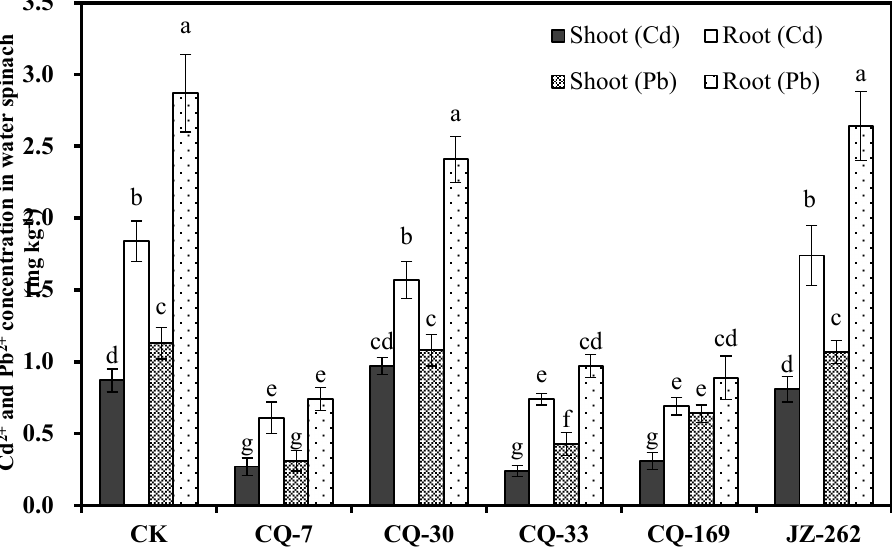
Figure 4. Effects of strains on the dry weight of water spinach in the 5 mg L − 1 Cd 2+ and 20 mg L − 1 Pb 2+ contaminated solution (x ± s). Error bars are ± standard error ( n = 3). Bars indicated by the di ff erent letter (a–h) were significantly ( p < 0.05) di ff erent according to Tukey’s test.